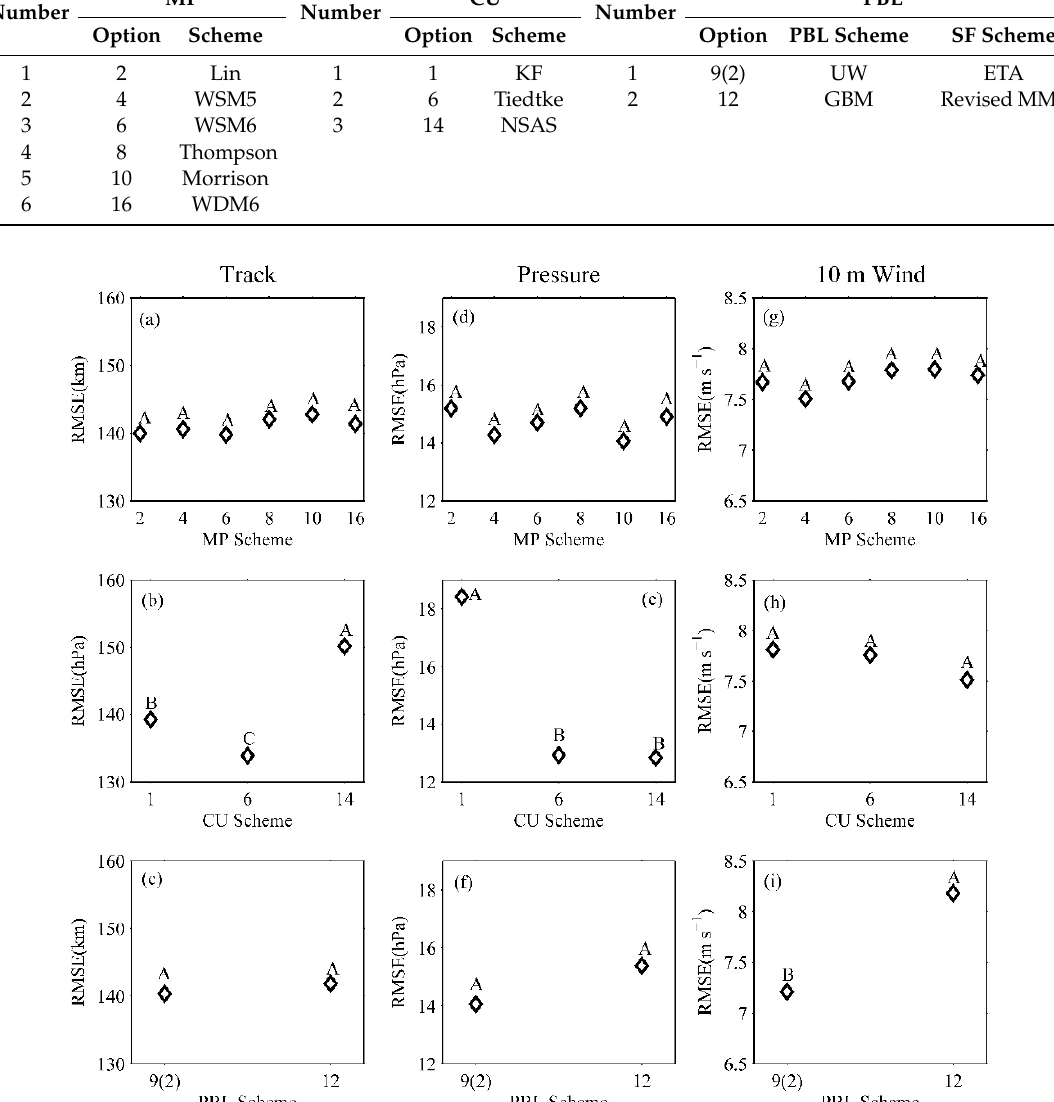
Figure 3. The fourth round of scheme evaluation results for the ( a )–( c ) track, ( d )–( f ) CSLP, and ( g )–( i ) 10 m wind of 15 typhoons using the Tukey’s test